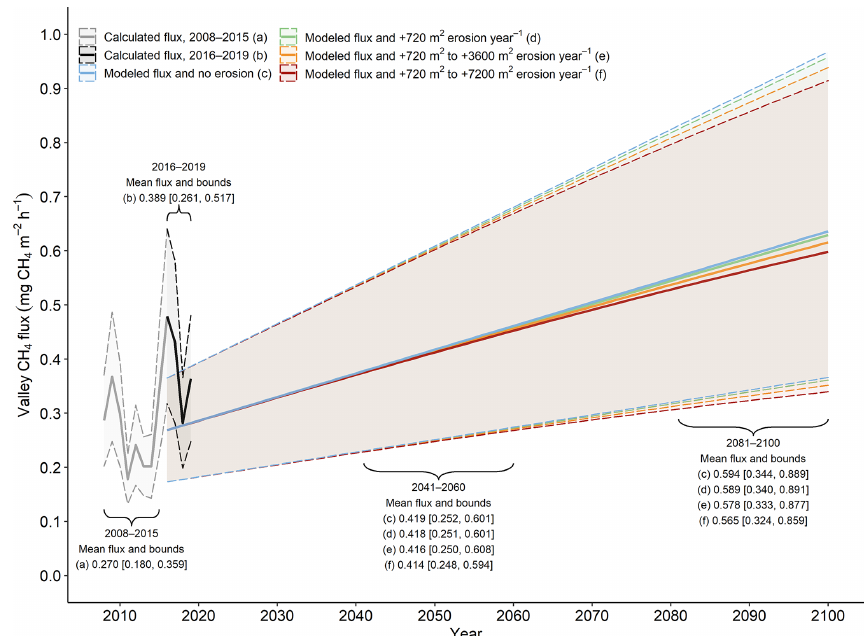
Figure 7. Methane fluxes in the valley floor study area increase over time if temperatures rise as modeled for the RCP8.5 scenario. However, increases in flux from rising temperatures are partly offset by erosion in the sensitivity study. Increasing erosion rates could reduce the mean flux of methane in the valley over time when a part of the landscape, a net source of methane, is converted into eroded areas with lower methane